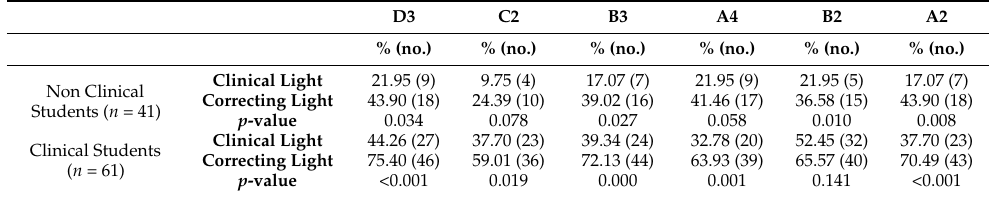
Table 2. Comparison of shade selection of non-clinical students and clinical students under clinical and correcting light.